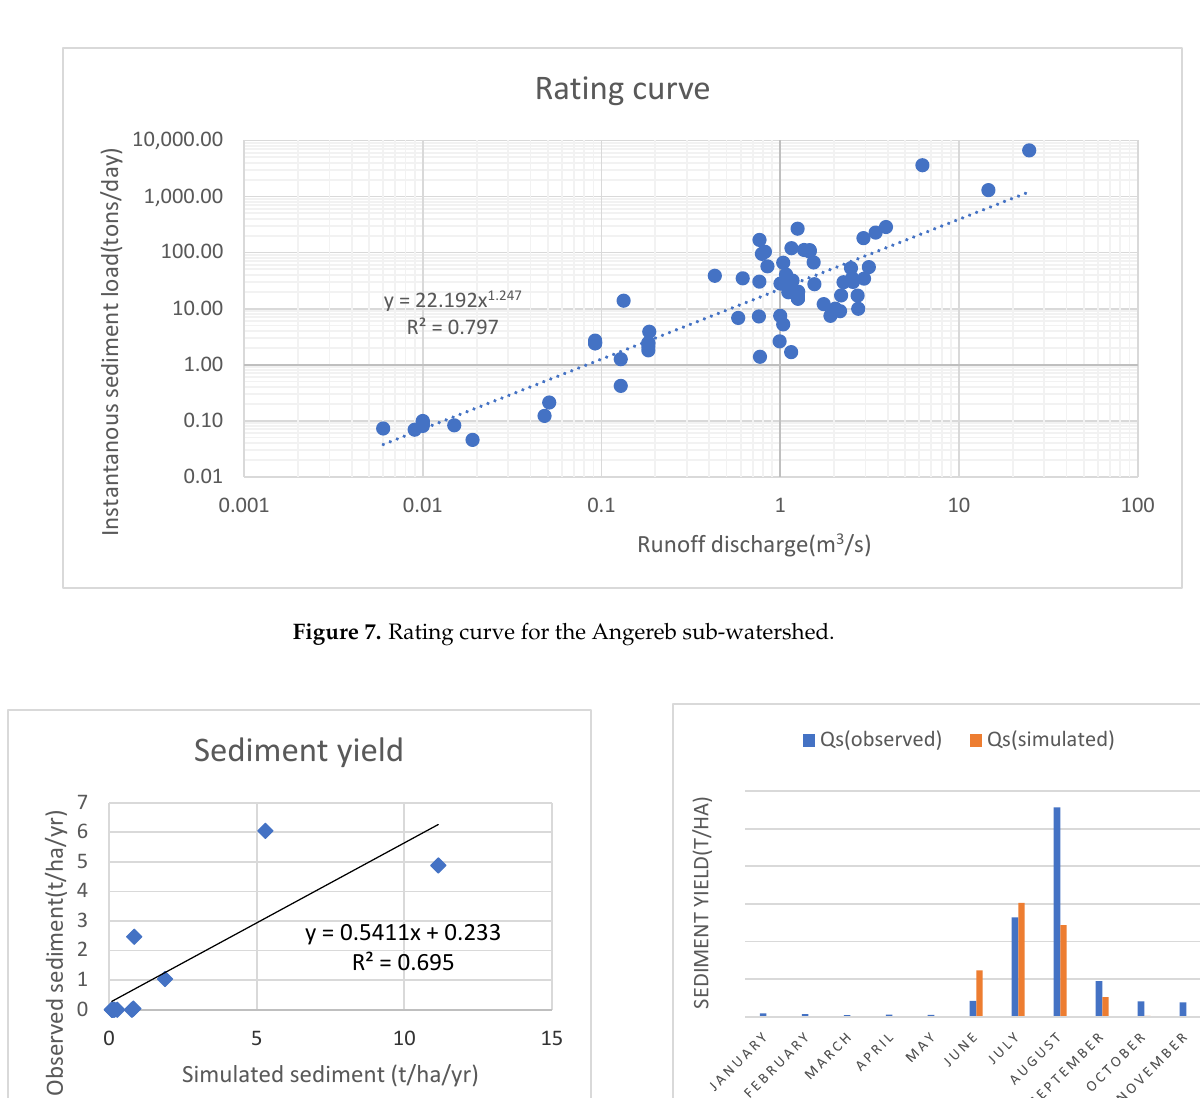
Figure 7. Rating curve for the Angereb sub-watershed.